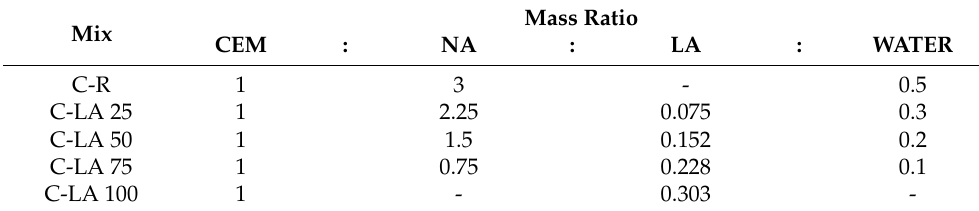
Table 2. Composition of reference and LA dosed concretes.